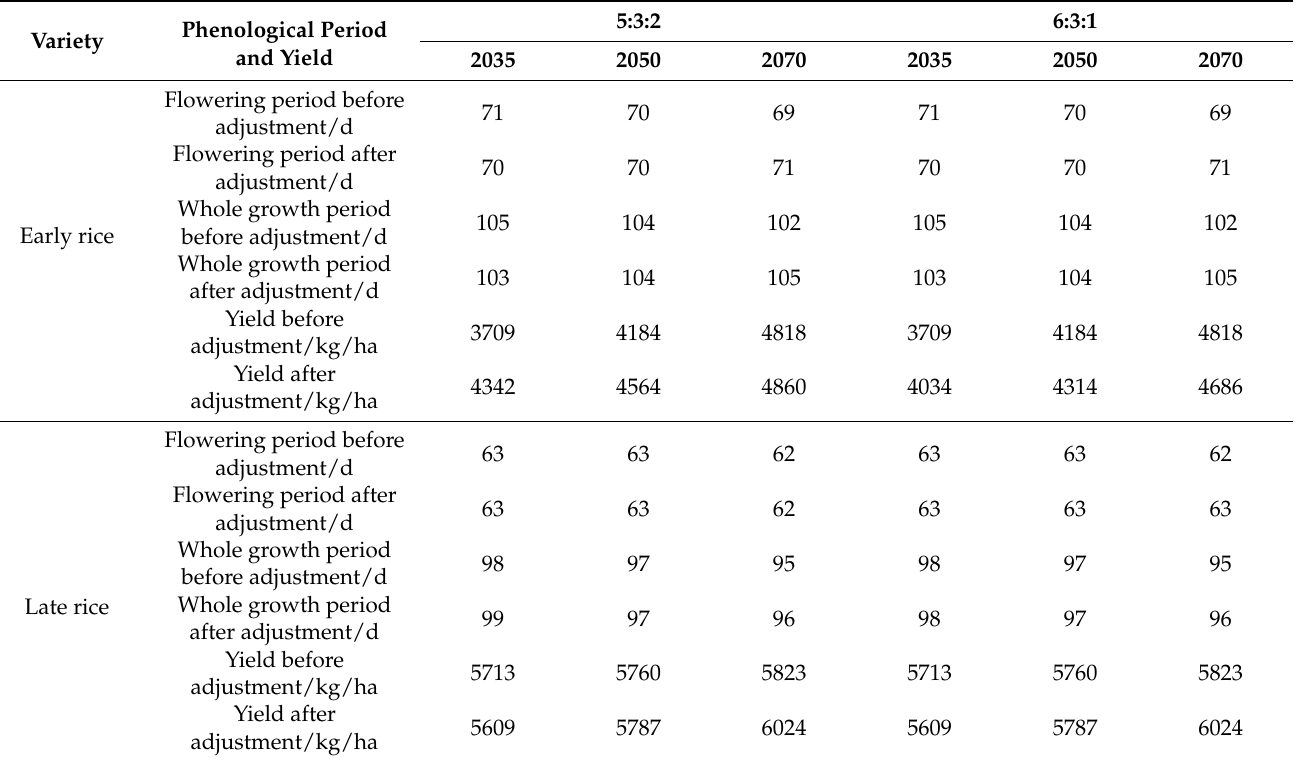
Table 6. Future changes of double-harvest rice yield and phenological period in Nanchang under the different nitrogen application